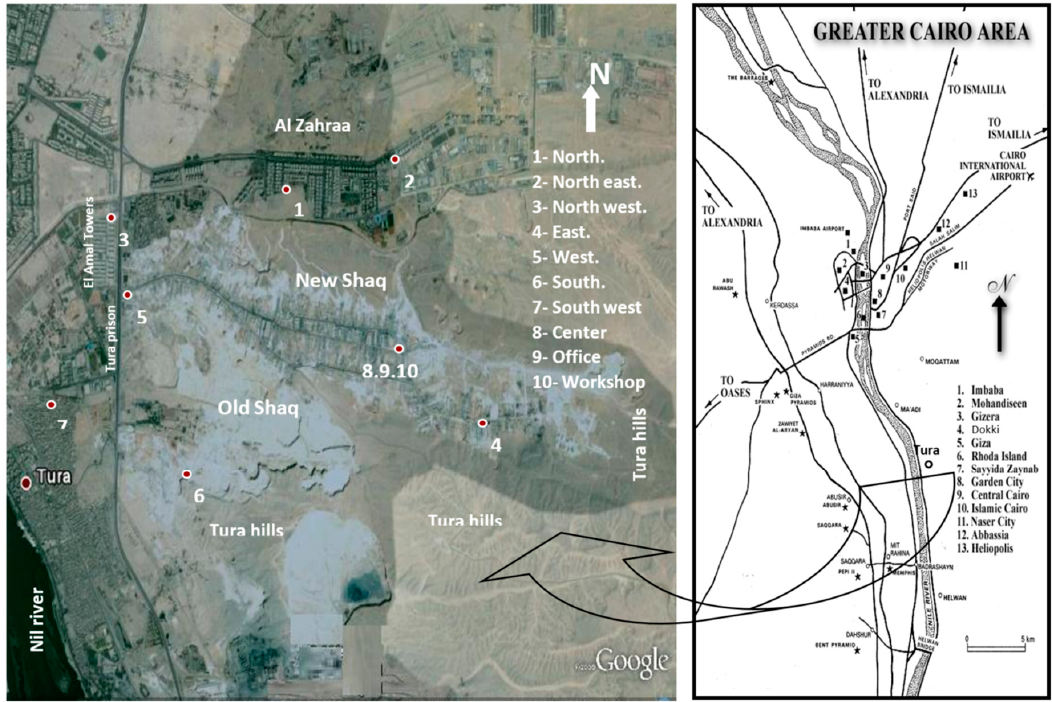
Figure 1. Location of the study area and observation sites.